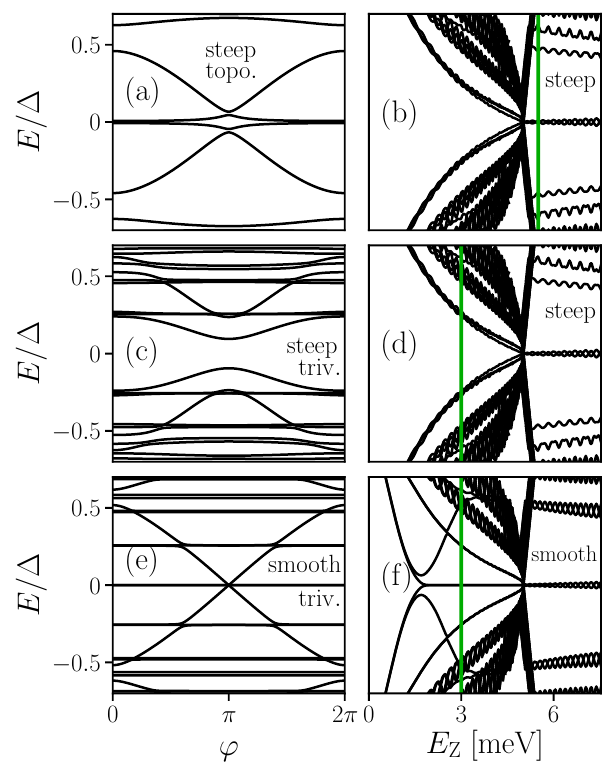
Figure 7: Energy levels in a topological Josephson junction as a function of the phase difference across the junction ϕ (left column), and as a function of Zeeman energy E (right column). Panels (a, b) show the energy levels in the topological phase with Z a steep barrier ( σ = 10 nm), panels (c, d) in the trivial phase with a steep barrier, and panels (e, f) in the trivial phase with a smooth barrier ( σ = 100 nm) in presence of quasi-Majorana states. The vertical green lines in the right panels indicate the Zeeman energy at which the corresponding left panel is computed. The barrier height and the chemical potential in all panels is V = 7.4 meV and µ = 5 meV